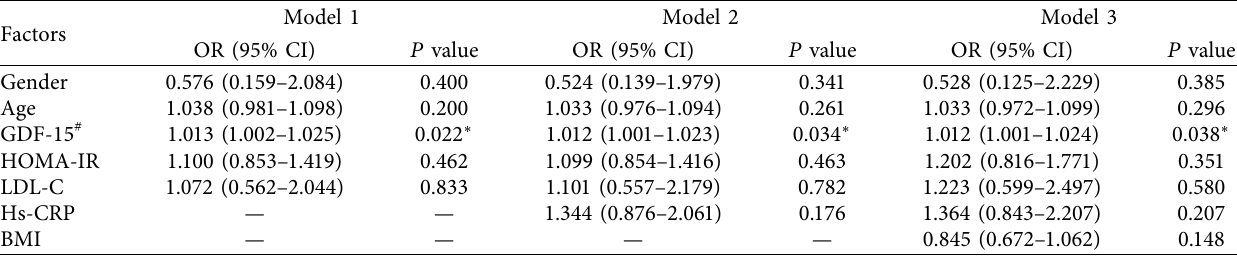
Table 2: Multivariate logistic regression